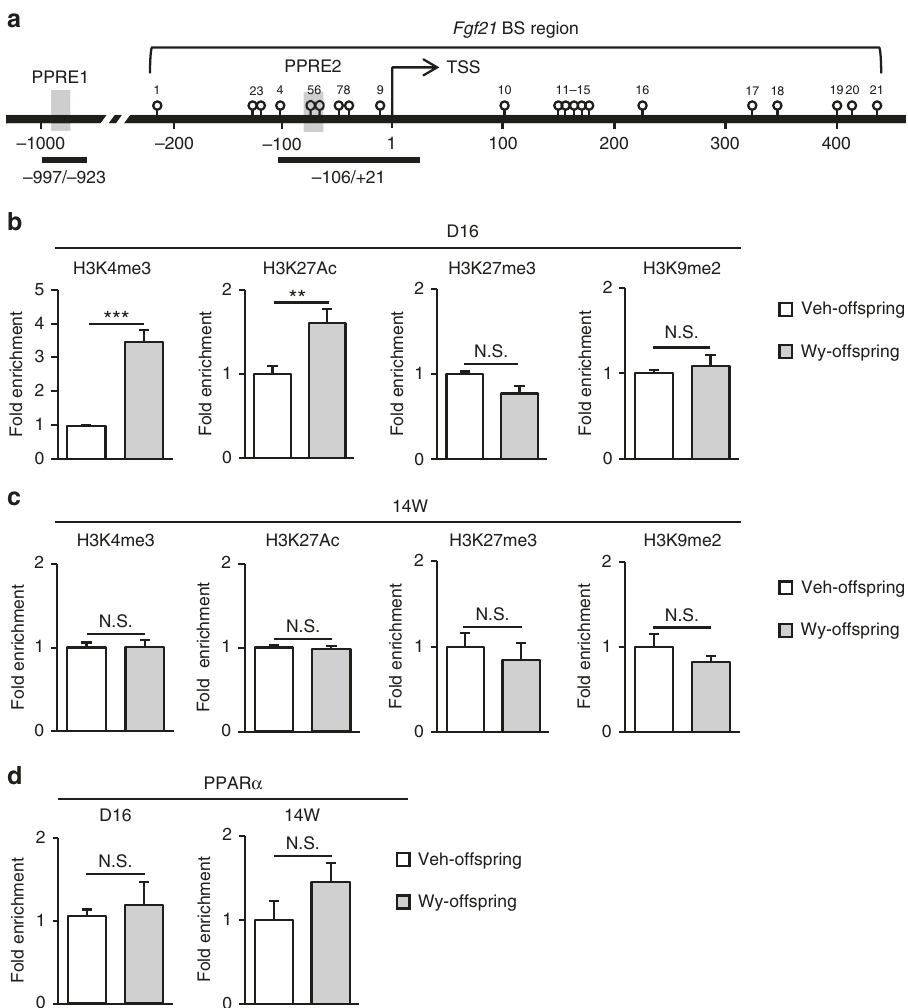
Fig. 4 Histone modi fi cations of Fgf21 in Wy-offspring. a Schematic representation of the promoter region of Fgf21 . Open circles and gray boxes indicate CpG sites and PPAR response elements (PPREs), respectively. BS, bisul fi te sequencing. b , c ChIP assays of histone marks in Wy- and Veh-offspring at D16 ( b ) and 14W ( c ), with the indicated antibodies. Primers amplifying the region of − 106 to +21 bp were used for ChIP-qPCR analysis ( n = 5 – 6 per group). d ChIP assays of the recruitment of PPAR α to PPRE1. Primers amplifying the region of − 997 to − 923 bp were used for ChIP-qPCR analysis ( n = 4 – 8 per group). Statistics by unpaired Student ’ s t -test. Data are expressed as mean ± SEM. ** P < 0.01; *** P < 0.001; N.S., not signi fi cant vs.